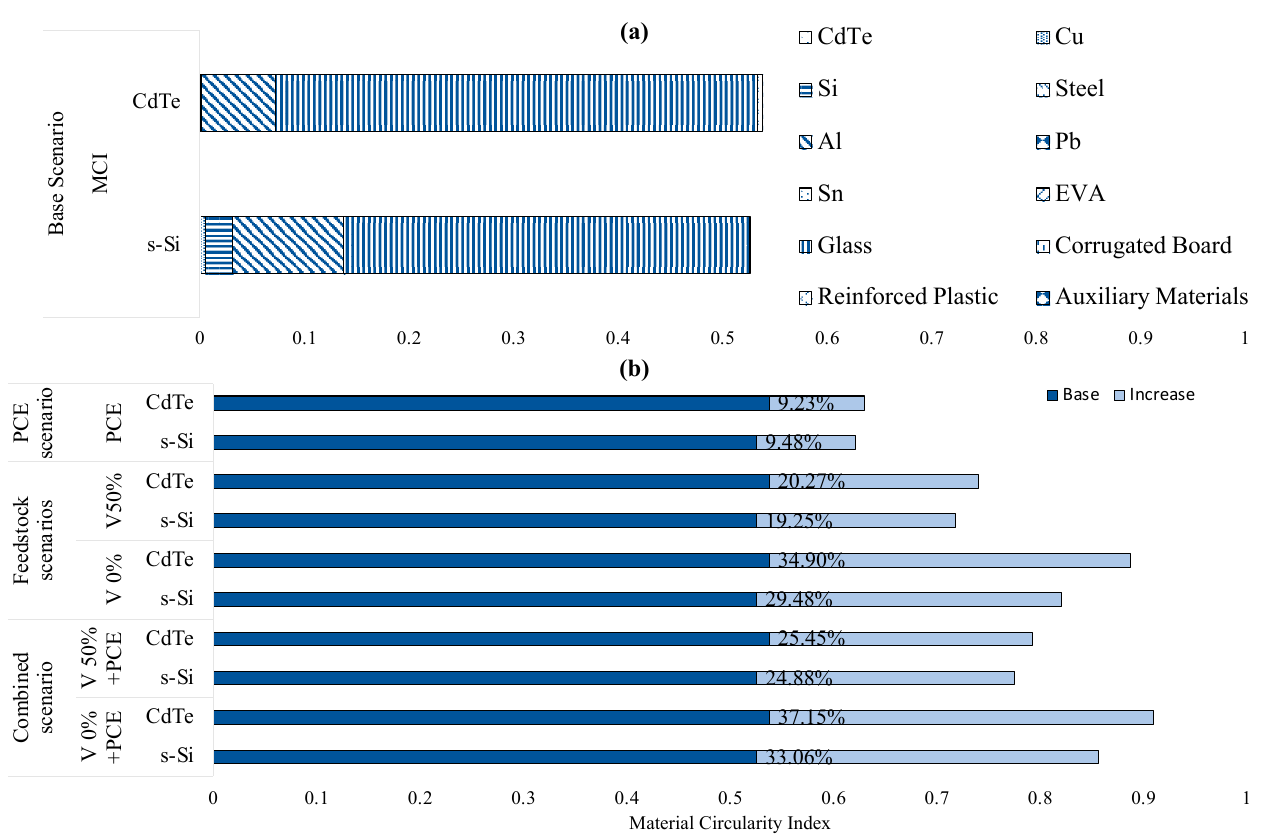
Figure 3. MCIs of CdTe and s-Si solar panels: ( a ) the impact of each PV component to the MCI metric, and ( b ) the impact of alternative scenarios, including the changed in PCE, virgin feedstock rates and their combinations on MCI metric. The increment (%) for each scenario is also shown with transparent bars in ( b ).